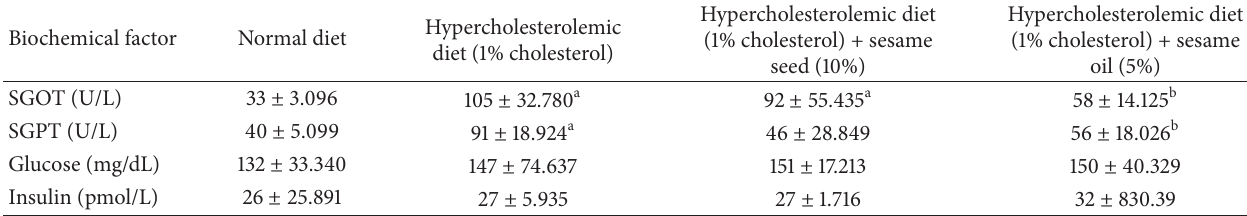
Table 2: Effects of Sesamum indicum on serum concentrations of liver enzymes, glucose, and insulin in experimental groups. Biochemical factor Normal